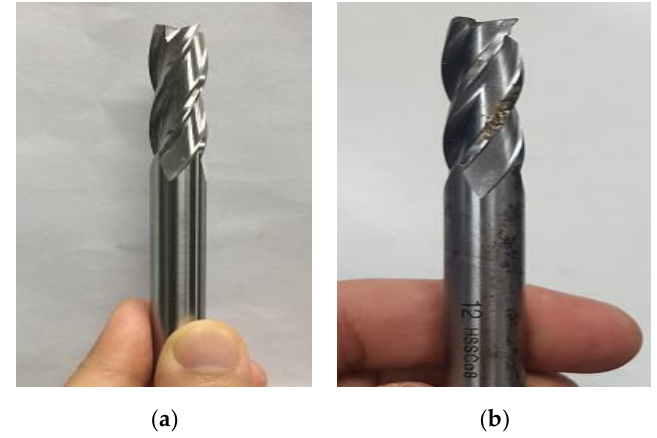
Figure 4. Illustration of drills’ bits: ( a ) healthy drill; and, ( b ) faulty drill with wear.